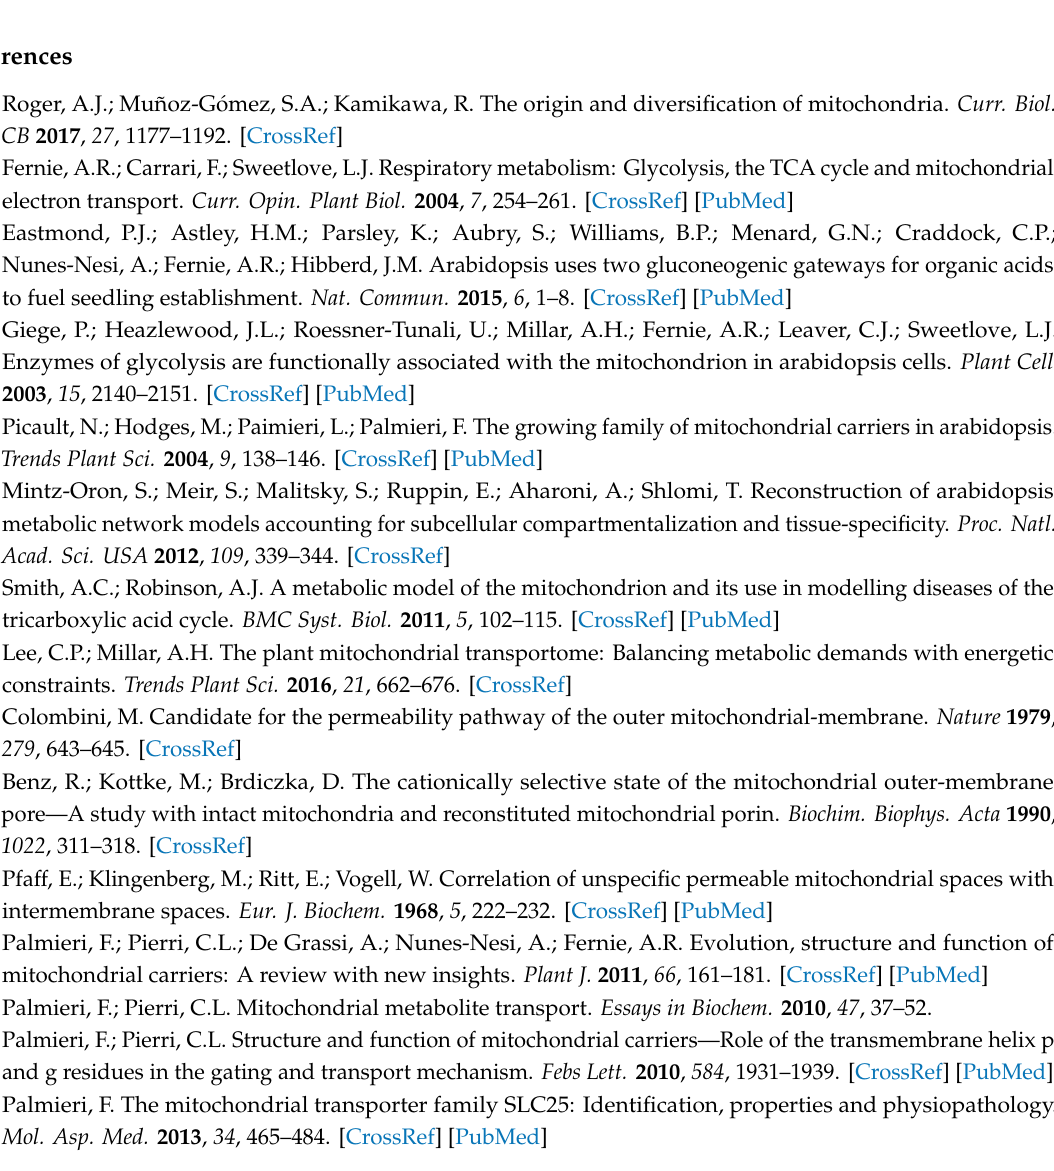
Table S1: Ortologous genes of plant mitochondrial carrier family retrieved from Plaza